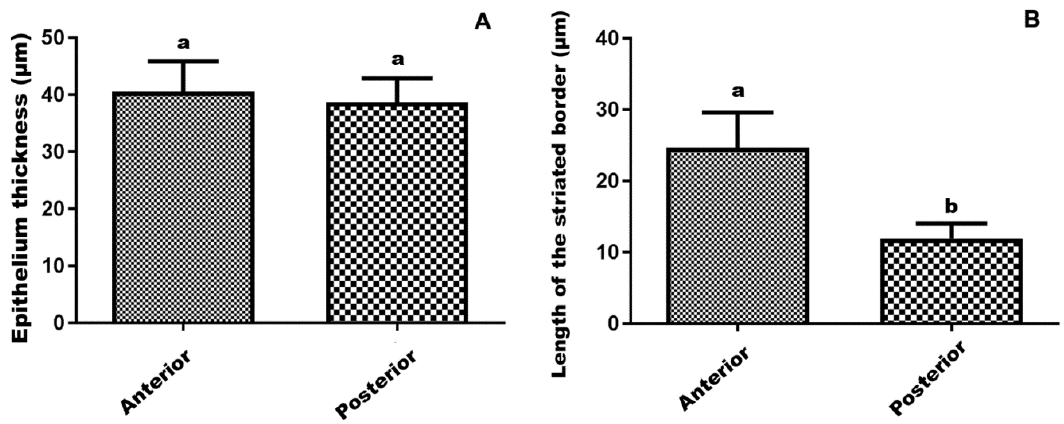
Figure 8. Morphometry of the midgut epithelium of Friesella schrottkyi worker. ( A ) Epithelium thickness (mean ± sd) in the anterior and posterior midgut regions. ( B ) Length (mean ± sd) of the striated border of the digestive cells in the anterior and posterior midgut regions. Different letters onto bars show differences between anterior and posterior midgut regions at 5% of significance level.